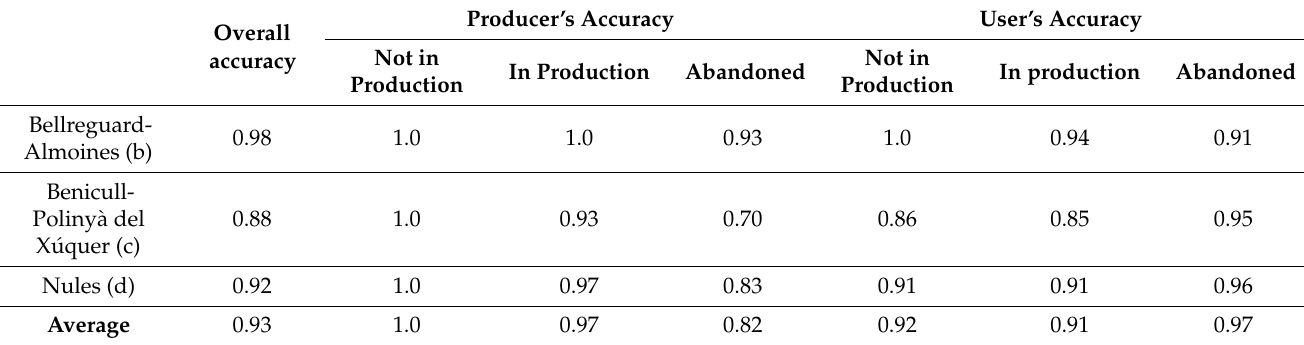
Table 5. Overall accuracy the in complementary